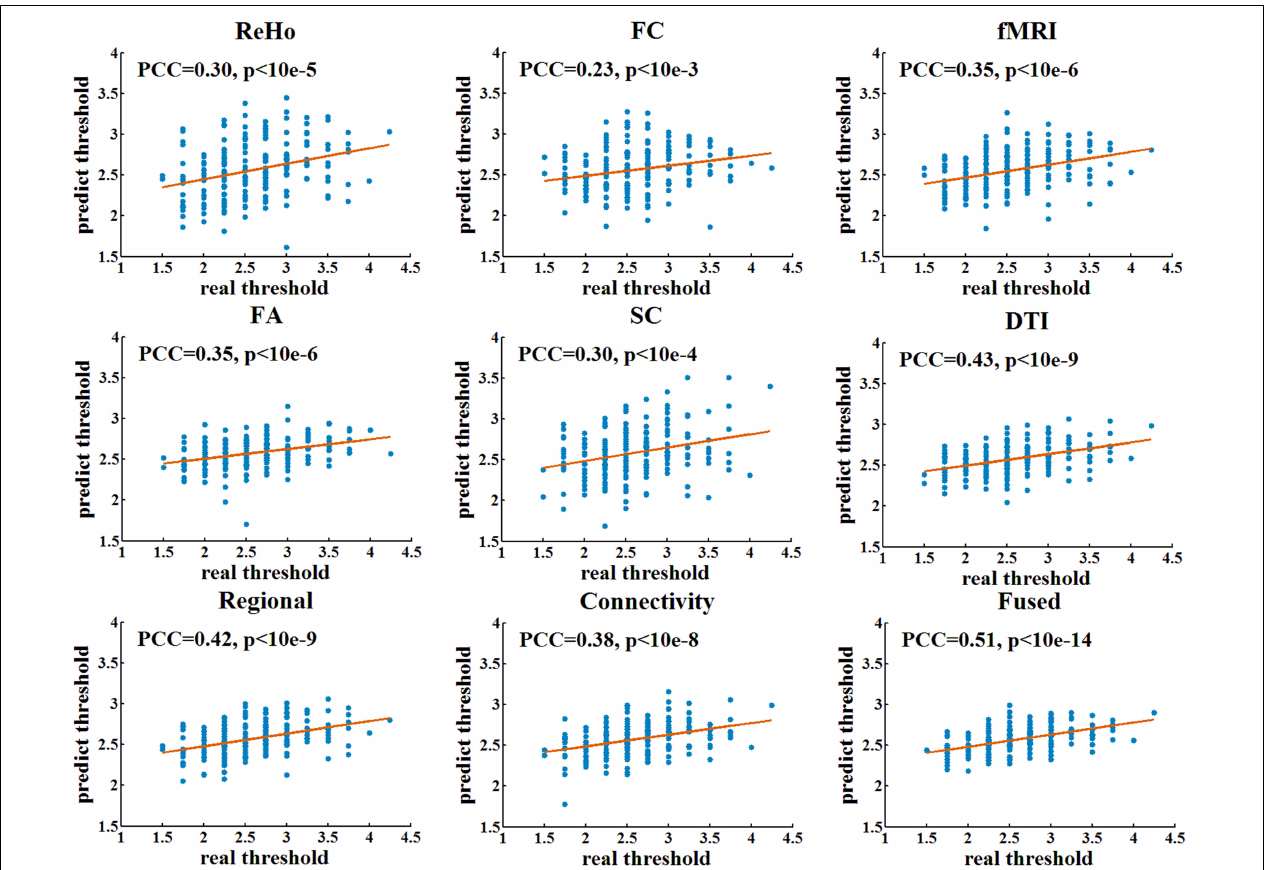
FIGURE 2 | The linear correlation between predicted and real pain thresholds. Each blue dot denotes one participant. Red lines are linear fitting lines.